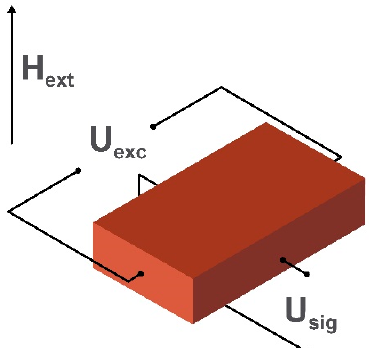
Figure 11. Schematic image of the sensing element of a Hall effect-based magnetometer, where the applied external magnetic field H ext is detected by the Hall voltage U sig orthogonal to an element current produced by a drive voltage U exc .